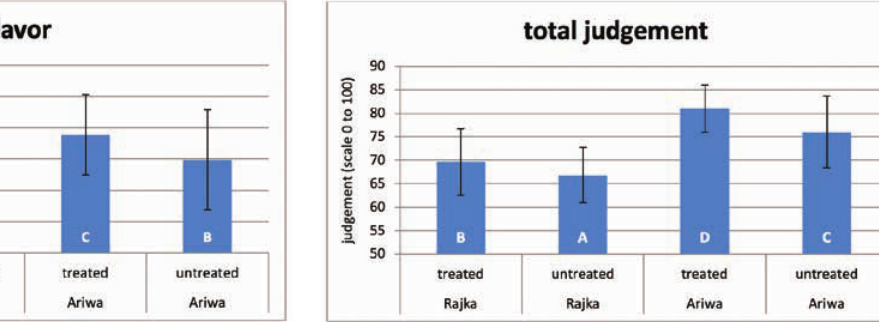
Figure 7: Crunchiness (mean ± SD, n without a same letter vary significantly, p ≤ 0.05)